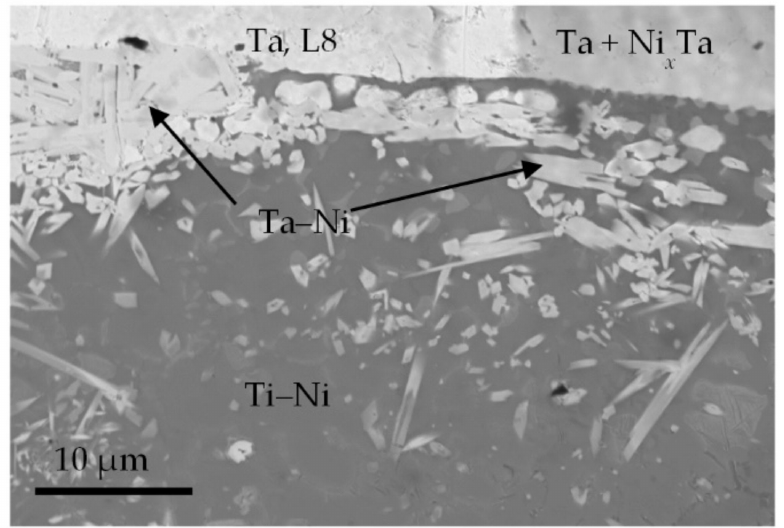
Figure 9. Microstructure of Ta–Ni–Ti interface (zone L8–L10, cross section of burned Set 1